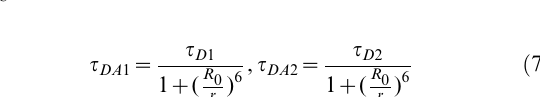
QD(520) and noncognate Tax-HLA-A2/QD(520) bound to the surface of CER43 CTL at indicated concentrations is presented. Figure S2 The extent of the equilibrium binding of noncognate pMHC/QD to the T-cell surface depends on the density of the pMHC ligands assembled on the dextran scaffold. Cognate (IV9-HLA-A2) or noncognate (Tax- HLA-2) proteins were assembled on a linear fluorescent-labeled dextran scaffold to yield p-HLA-A2/dextran oligomers containing either 4 (left panels) or 40 (right panels) pHLA-A2 arms per dextran molecule of the same length. The cognate and noncognate oligomers were incubated with 68A62 CTL for 30 minutes and the amount of IV9-HLA-A2/dextran or Tax-HLA-A2/dextran asso- ciated with the surface of the CTL was determined by flow cytometry. Actual ( A and B ) and normalized ( C and D ) values of MFI at various concentrations of the tested IV9-HLA-A2/dextran or Tax-HLA-A2/dextran conjugates are shown. Figure S3 The binding kinetics of pMHC/QD and pMHC/Streptavidin oligomers to the surface of 68A62 CTL as established by flow cytometry. The binding kinetics of various QD(520)-based conjugates (red), i.e., strong agonist IV9- HLA-A2/QD ( A ), a weak agonist A6-HLA-A2/QD ( B ) or IV9- HLA-A2 mut /QD containing HLA-A2 mutant (A245V) ( C ), was compared with binding kinetics of Streptavidin-based conjugates (blue) containing either IV9-HLA-A2 ( A ) or A6-HLA-A2 ( B ) or IV9-HLA-A2 mut ( C ) to 68A62 CTL. The conjugates were added to the extracellular medium (25 nM) at time zero. Aliquots were taken at indicated time points and MFI associated with the CTL was measured by flow cytometry. The dependence of the MFI vs time is shown. Figure S4 Kinetics of TCR-mediated Ca 2 + signaling in 68A62 CTL induced by IV9-HLA-A2/QD(520) or IV9- HLA-A2/QD/Streptavidin oligomers at various concen- trations. IV9-HLA-A2/QD(520) ( A ) or IV9-HLA-A2/QD/ Streptavidin ( B ) oligomers were added to the extracellular medium of Fluo-3 labeled 68A62 CTL at indicated concentration, and changes in the fluorescent intensity of Fluo-3 as a function of time were measured by flow cytometry. The data were analyzed with FlowJo software. From the initial increase of intracellular Ca 2 + , we have determined slope for each kinetic curve. The dependence of the slope upon concentration for both oligomers is presented on panel C . Figure S5 The influence of the density of cognate pMHC displayed on QD of different sizes on the Ca 2 + signaling kinetics induced in 68A62 CTL. Kinetics of intracellular Ca 2 + accumulation in Fluo-3 labeled 68A62 CD8 + CTL stimulated with cognate IV9-HLA-A2 ligands assembled on a smaller QD(520) (red trace) or a larger QD(620) (green trace) scaffolds with the same geometry. Left: the density of IV9-HLA-A2 proteins (red) on the 2 probes was similar, while the valency on the 2 probes differed by a factor of 4, i.e., 10/dot and 40/dot, respectively. Right: cognate IV9-HLA-A2 (red) on QD(620) were diluted by inactive Tax-HLA-A2 mut molecules (grey) to decrease the density of the cognate ligands by 4-fold, but keeping their valency similar to that on QD(520), i.e., 10/dot. Representative results are shown. Figure S6 Quantification of the number of pMHC molecules per dot in pMHC/QD conjugates. His 6 - terminated IV9-HLA-A2 proteins were combined with QD